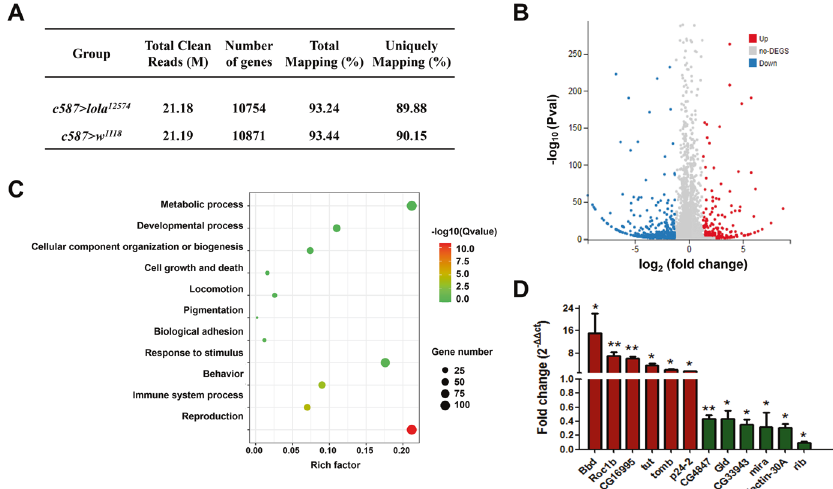
Fig. 6 RNAi of lola in the ovary results in transcript alterations as assessed by RNA-seq analysis. A The numbers of total clean reads, number of genes, total mapping and unique mapping for each sample. B Volcano plot of differentially expressed genes (DEGs) in the ovary of c587 > lola 12574 RNAi line relative to the c587 > w 1118 control. C GO analysis of DEGs from comparison of the c587 > lola 12574 RNAi and c587 > w 1118 control groups. D qRT-PCR validation of select DEGs from RNA sequencing data. Signi fi cant difference was determined by the student ’ s t-test and indicated by * p < 0.05 and ** p <